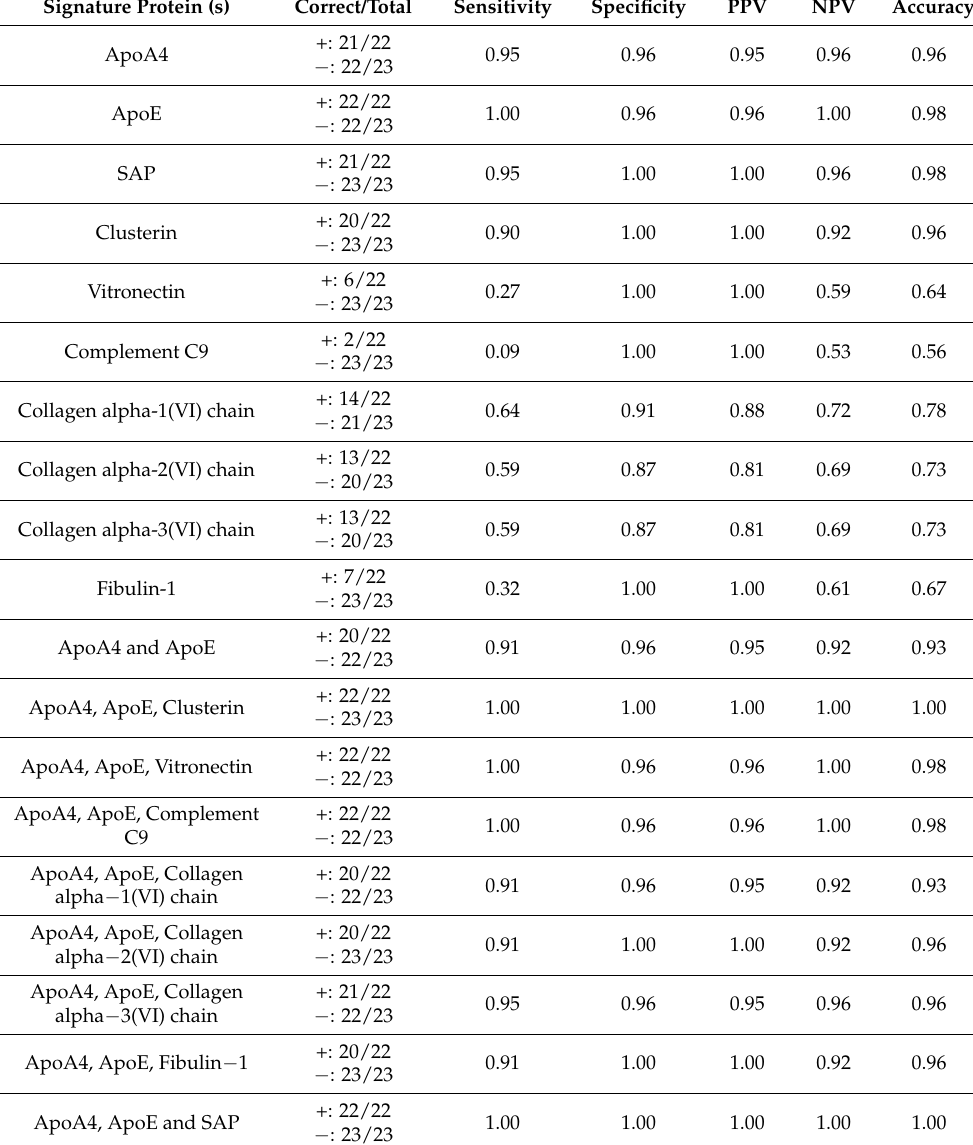
Table 2. The capability of the identified amyloid signature proteins, and combinations of these, to discriminate amyloid-containing biopsies from CR-negative samples. Support Vector Machine algorithm was developed based on the quantitative readout (number of peptide spectrum matches) of each of the identified amyloid signature protein (Table 1) from the proteomics analysis of the biopsies from the training set. The test data set consisted of 22 amyloid-containing biopsies (“+”) and 23 corresponding controls without amyloid (“ − ”).